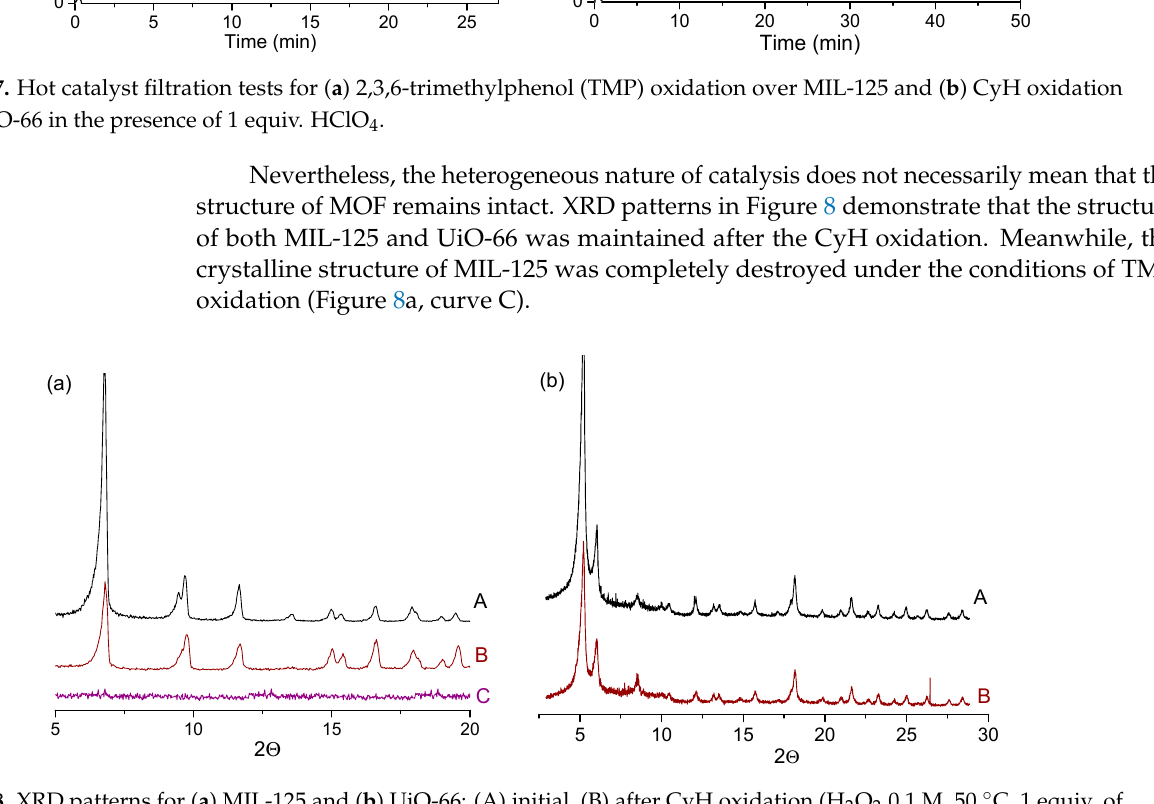
Figure 8. XRD patterns for ( a ) MIL-125 and ( b ) UiO-66: (A) initial, (B) after CyH oxidation (H 2 O 2 0.1 M, 50 °C, 1 equiv. of HClO 4 ) and (C) after TMP oxidation (H 2 O 2 0.4 M, 80 °C) .